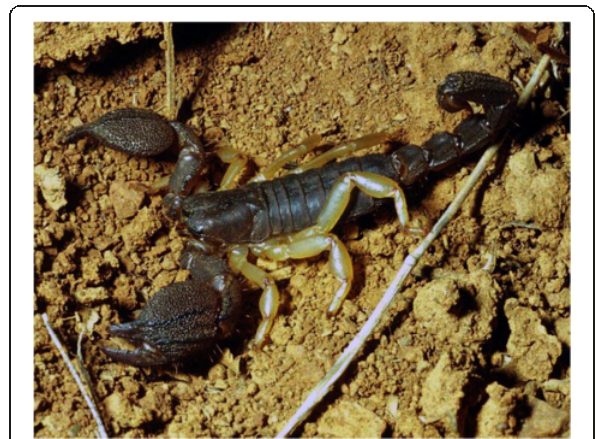
Fig. 13 Scorpio maurus Linnaeus, 1758; male from Tunisia